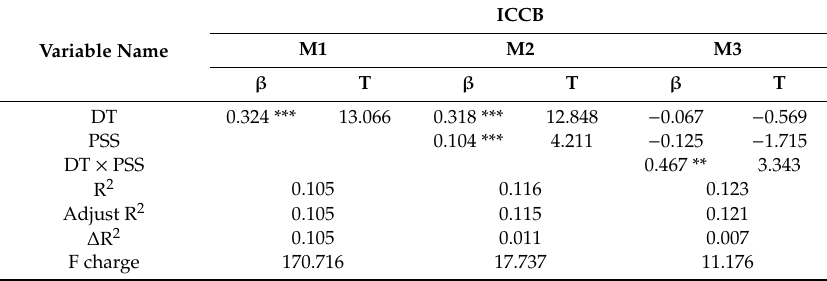
Table 5. The test of moderating e ff